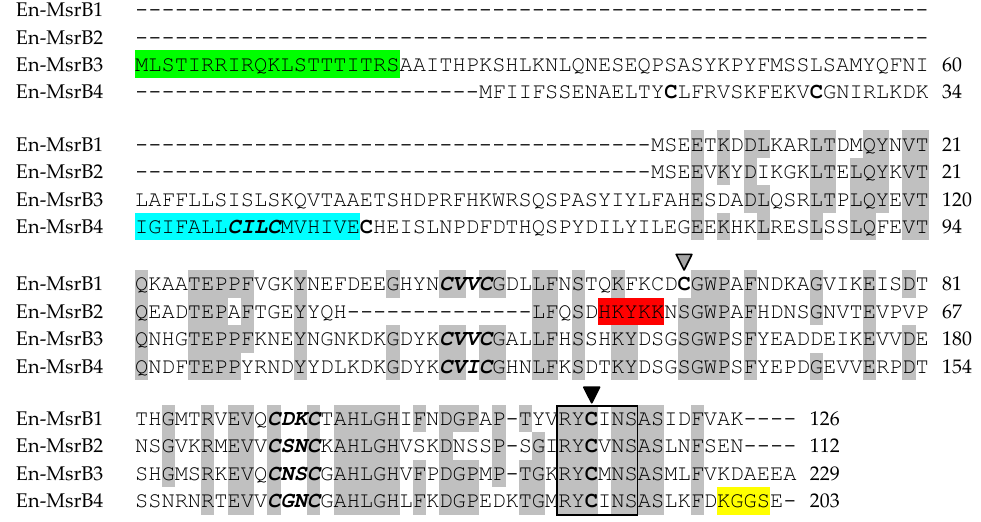
Figure 2. Amino acid sequence alignment of the En-MsrB proteins. The alignment was maximized by gap insertion and residues identical in three or four sequences are highlighted in grey. The CXXC motifs are in bold and italics. The resolving and catalytic cysteines are indicated by grey and filled arrowheads, respectively. The conserved catalytic site is boxed. Signals for mitochondrial targeting, nuclear translocation, transmembrane domain and ER retention are highlighted in green, red, blue and yellow, respectively.